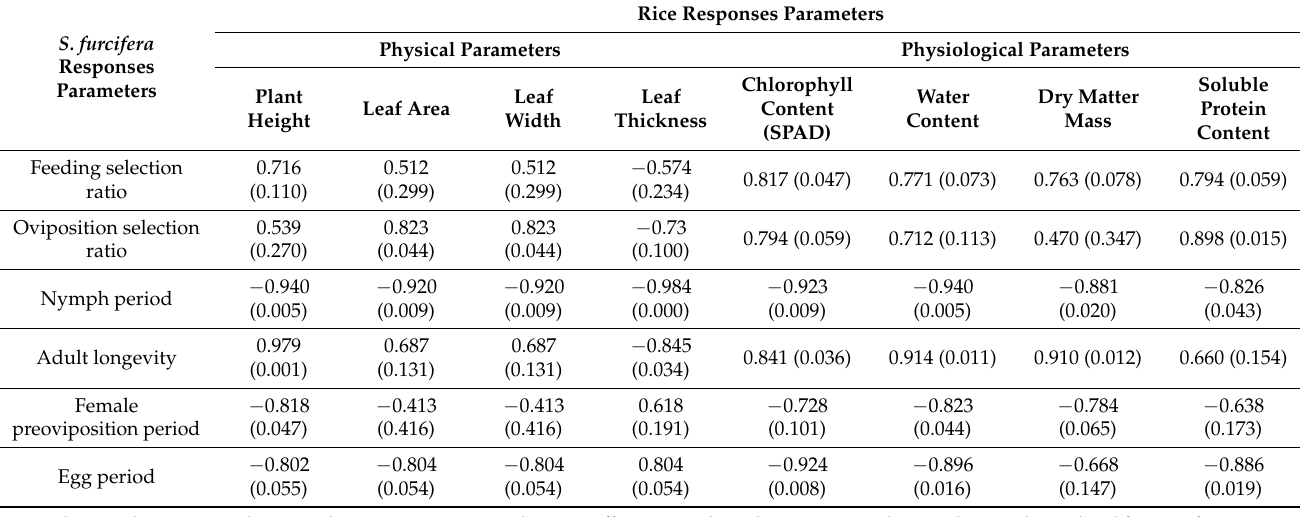
Table 7. Pearson’s correlation coefficients and p -values between S. furcifera and rice responses to different nitrogen fertilizer